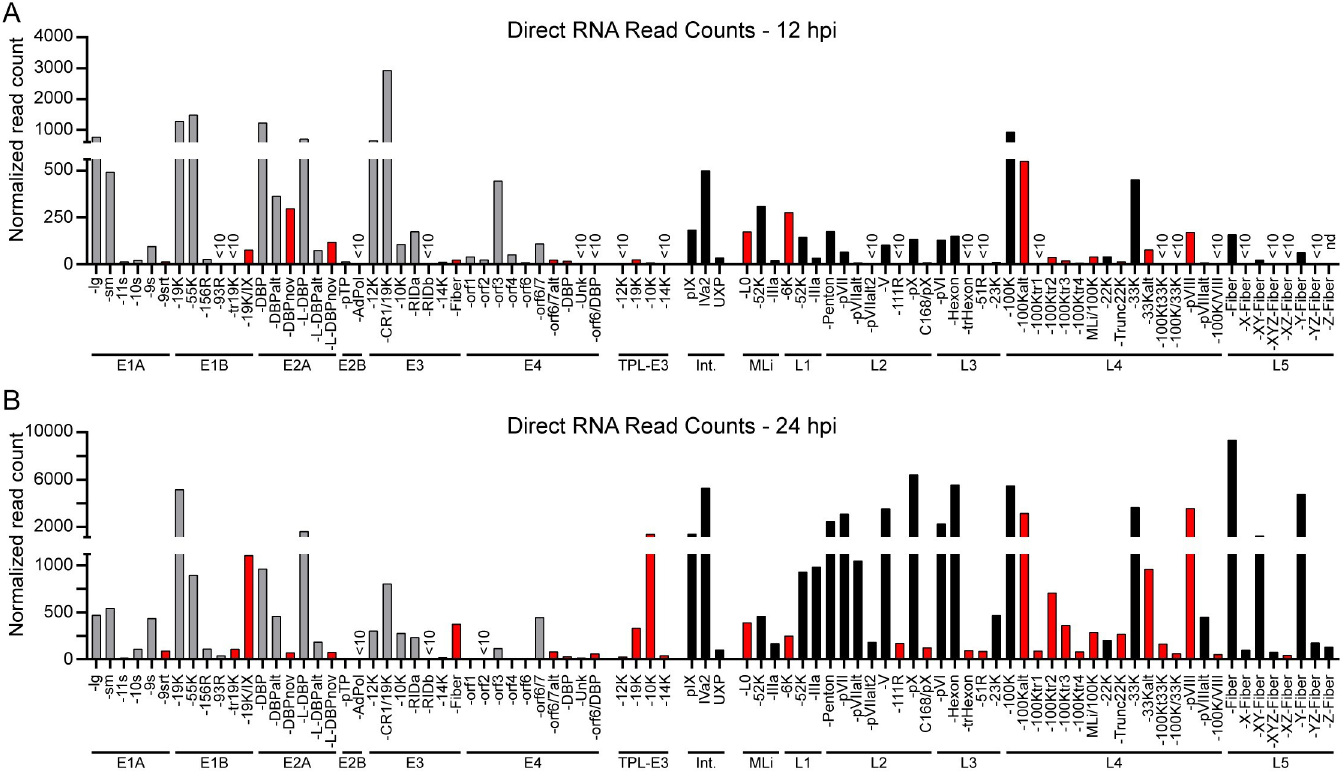
Fig 3. Direct RNA Sequencing (dRNA-seq) unambiguously distinguishes early and late transcription. (A) dRNA-seq was performed on polyadenylated RNA from Ad5-infected A549 cells extracted at 12 hours post-infection (hpi). Sequence reads were aligned to the re-annotated transcriptome and filtered to retain only unambiguous primary alignments. Normalized read count indicates the number of RNAs for a particular transcript once normalized to the total number of mappable reads (human plus adenovirus) for the entire sequencing reaction. For all panels, grey bars indicate early genes, black bars indicate late genes, and red bars indicate novel isoforms discovered in this study. Undetectable transcripts (nd) or those with fewer than 10 counts of a particular isoform detected ( < 10) are indicated. (B) Same as in Panel A, but with RNA harvested at 24 hpi.